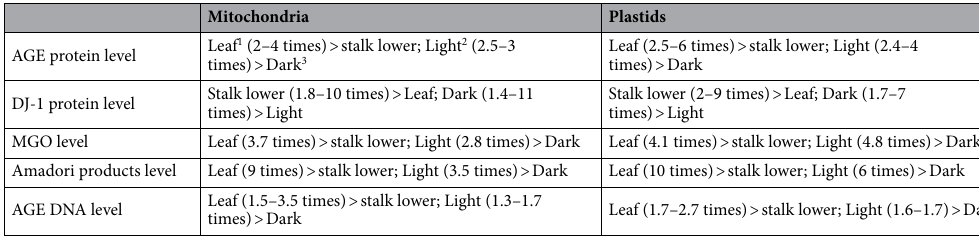
Table 1. Summary of results from the assays. 1 Leaf (L1). 2 Total leaves (L1 + L2 + L3) grown in light. 3 Total leaves (L1 + L2 + L3) grown in